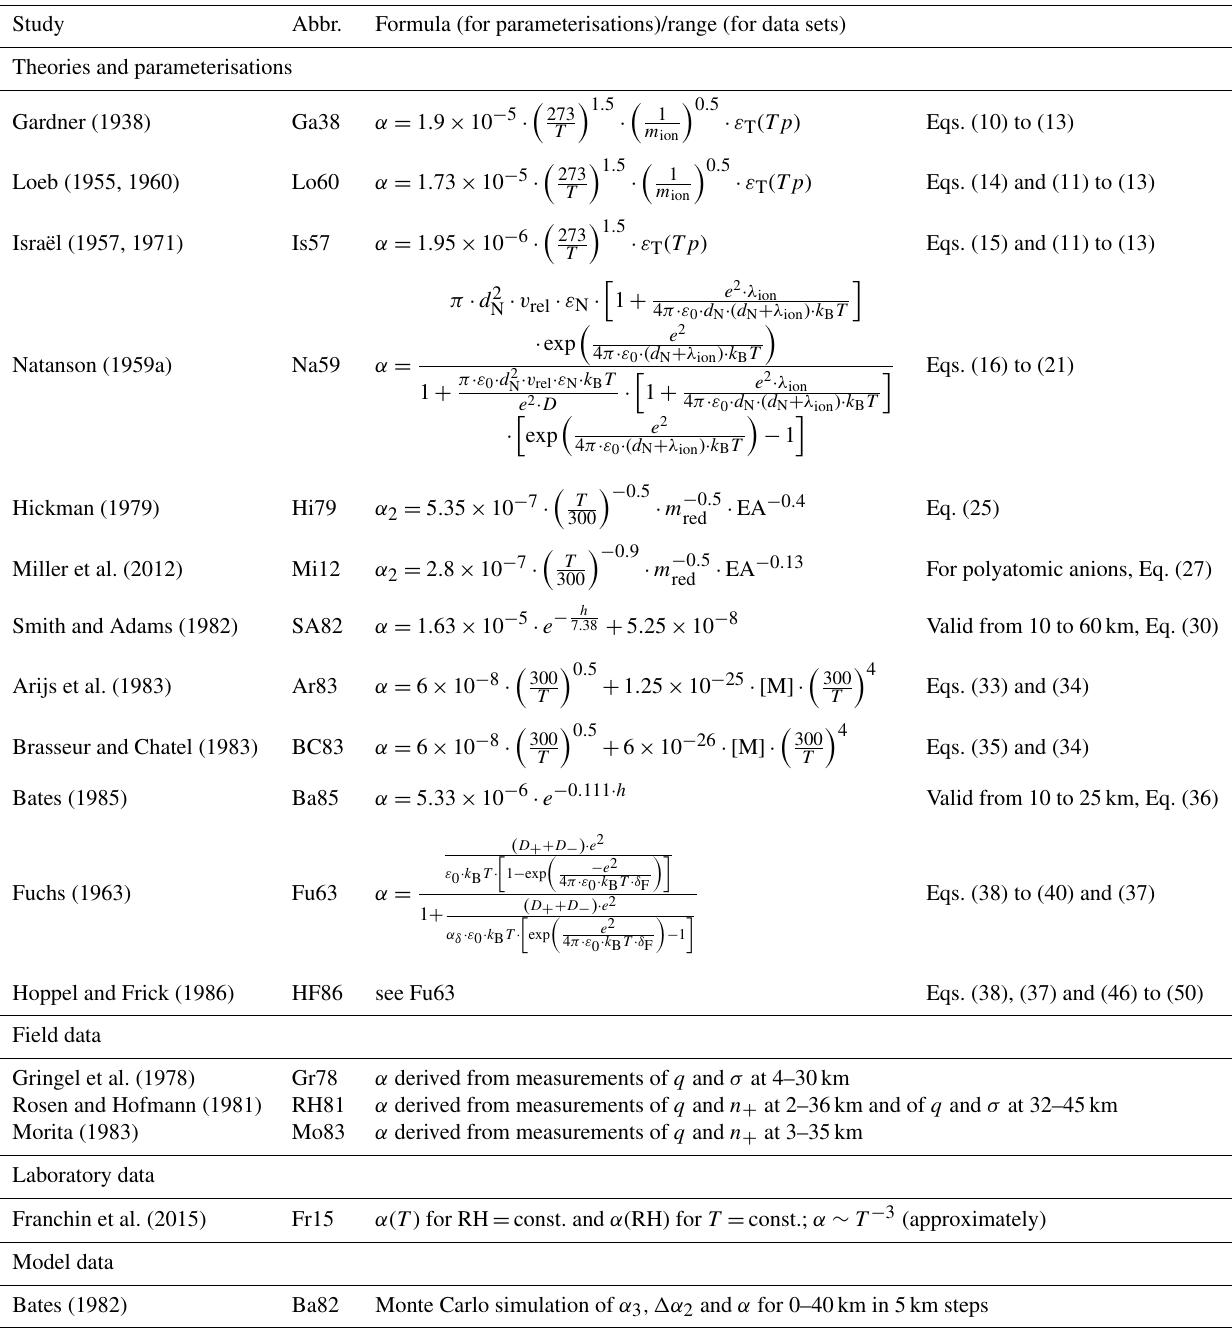
Table 2. List of all theories, parameterisations, data sets, and models used for comparison. Study Abbr. Formula (for parameterisations)/range (for data sets) Theories and